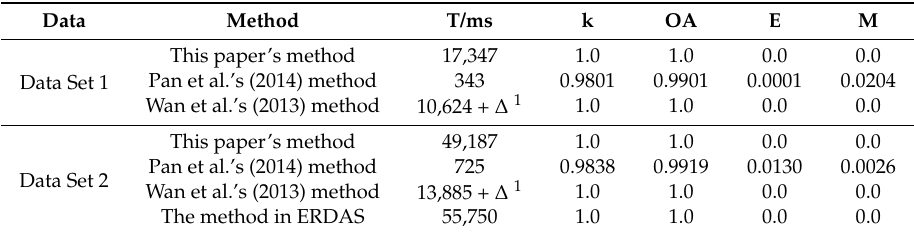
Table 2. Quantitative